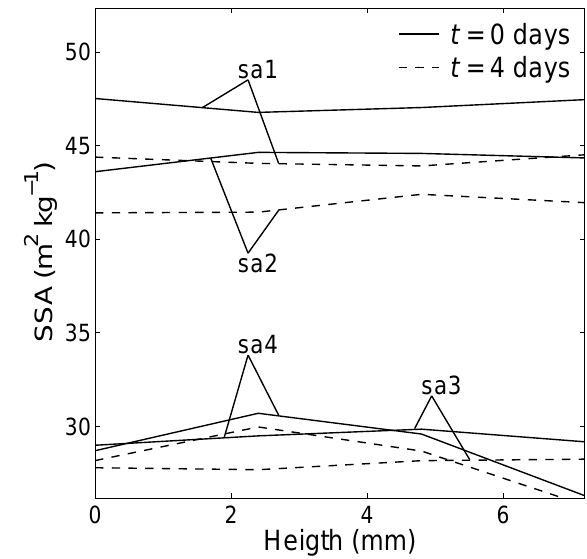
Figure 7. Spatial porosity profile of the scanned area at the be- ginning and at the end of each experiment. The spatial variabil- ity within the reconstructed volume was measured in four discs of 7 . 2mm × 7 . 2mm × 1 . 8mm.